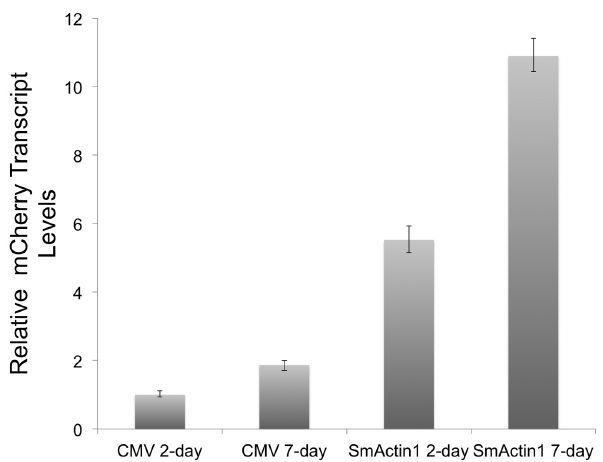
Figure 11. qRT-PCR quantitation of the mCherry transcript in schistosomes transfected with vectors expressing a reporter gene at day 2 and day 7. The viral promoter CMV and the endogenous schistosome promoter SmActin1 were assayed for their ability to express an mCherry reporter at different time frames, without maintaining the schistosomula under transfection